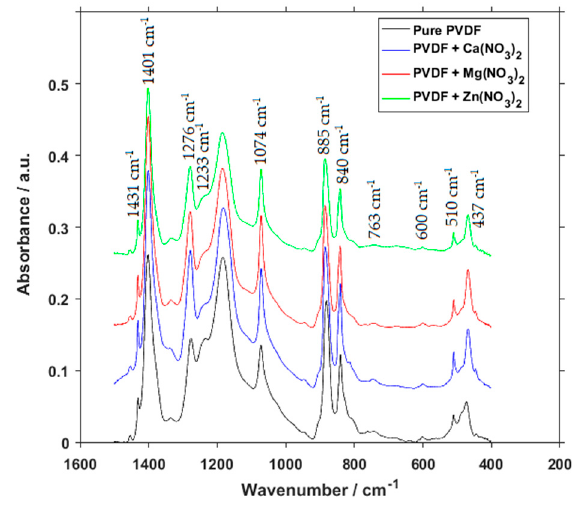
Figure 5. FTIR spectra of pure PVDF fibers and PVDF fibers with Ca(NO 3 ) 2 , Mg(NO 3 ) 2 and Zn(NO 3 ) 2 .